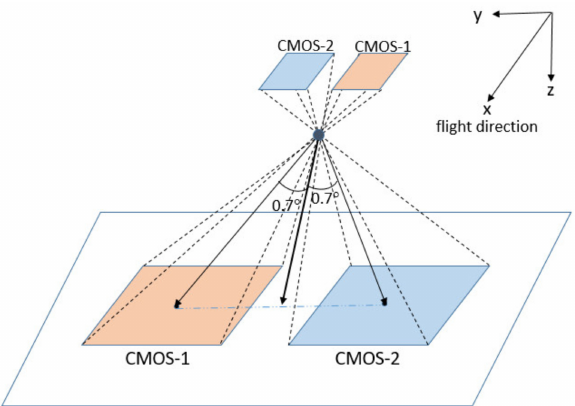
Figure 1. Schematic diagram of the relationship between the focal plane of the footprint camera and the ground